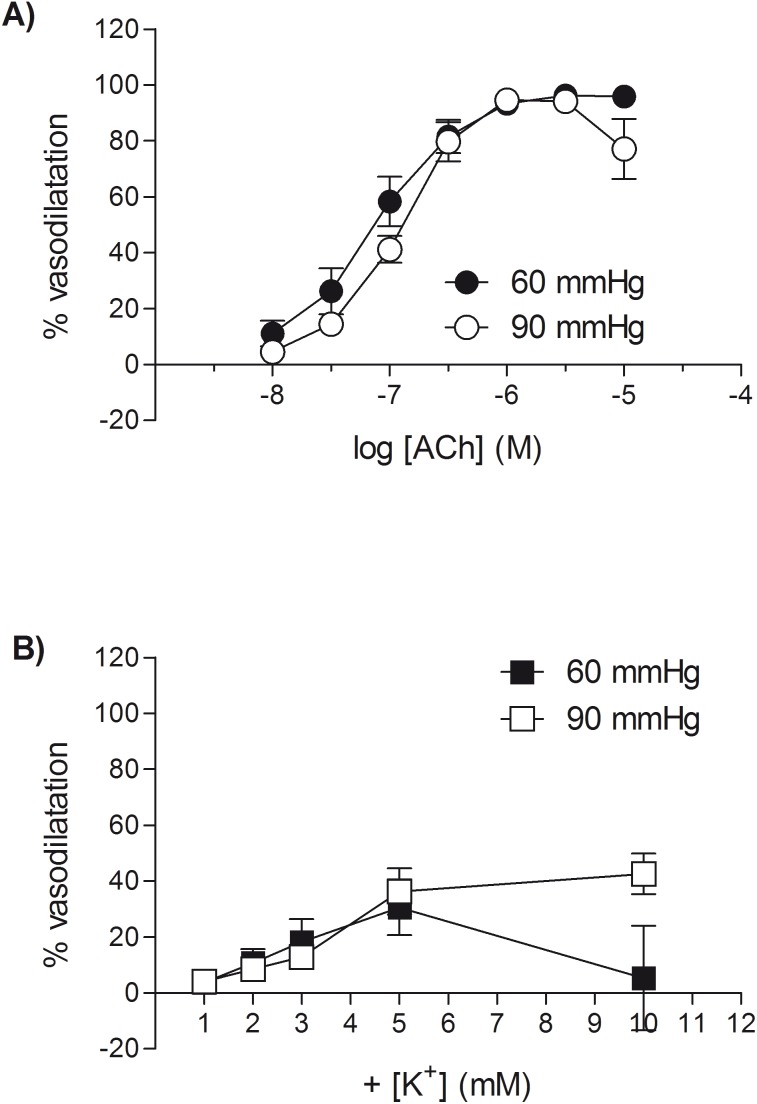
ACh produces a larger vasodilator response than raising extracellular potassium in myogenically-active mesenteric small arteries.Vasodilator responses to (A) ACh and (B) raised extracellular potassium in rat isolated mesenteric small arteries pressurised to 60 mmHg or 90 mmHg (in the presence of L-NAME and indomethacin). Following the development of stable myogenic tone, cumulative concentration response curves were constructed to ACh or potassium in random order in the same artery from n different animals. Each point represents the mean ± s.e.mean (n = 6–9).